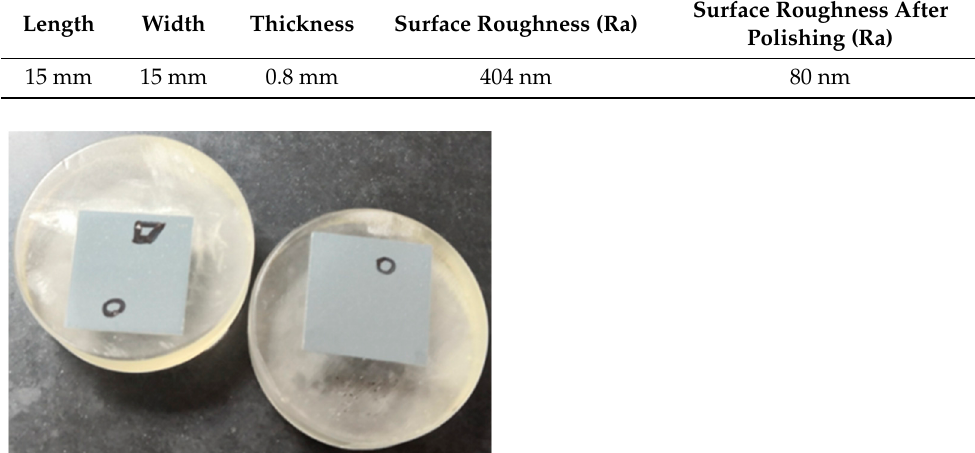
Figure 1. Photos of polished surfaces of silicon nitride ceramic specimens prepared for scratching and indentation experiments.